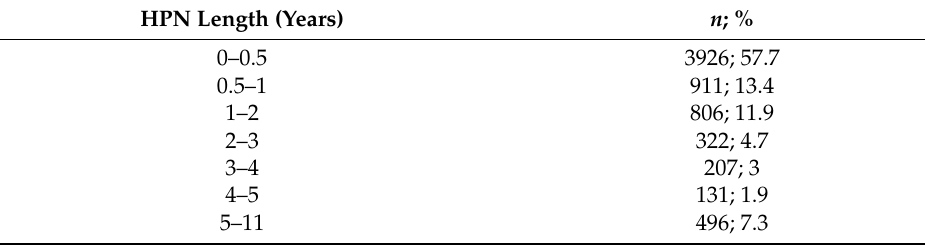
Table 6. HPN length.